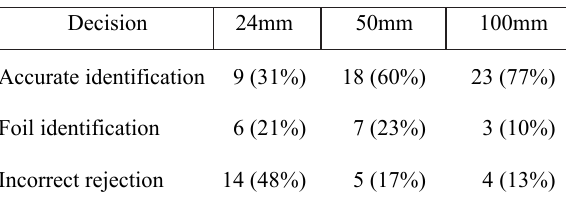
Table 1. Identification decisions as a function of different focal